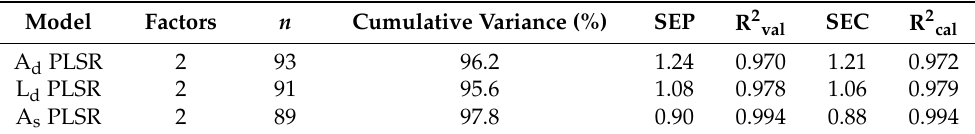
Table 10. Parameters associated with each partial least square regression (PLSR) model. Abbrevia- tions used: n refers to the number of spectra used to create the model; A d PLSR, A. diaperinus dough PLSR model; L d PLSR, L. migratoria dough model; and A s PLSR, A. diaperinus 3D-printed baked snacks PLSR